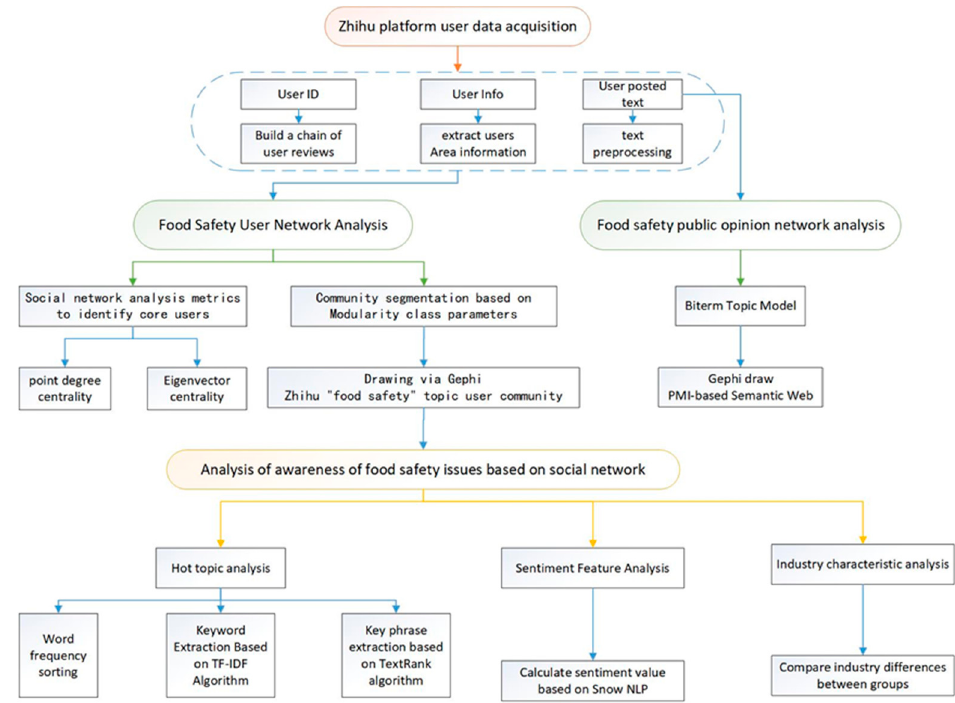
Figure 1. The methodological approach followed in this